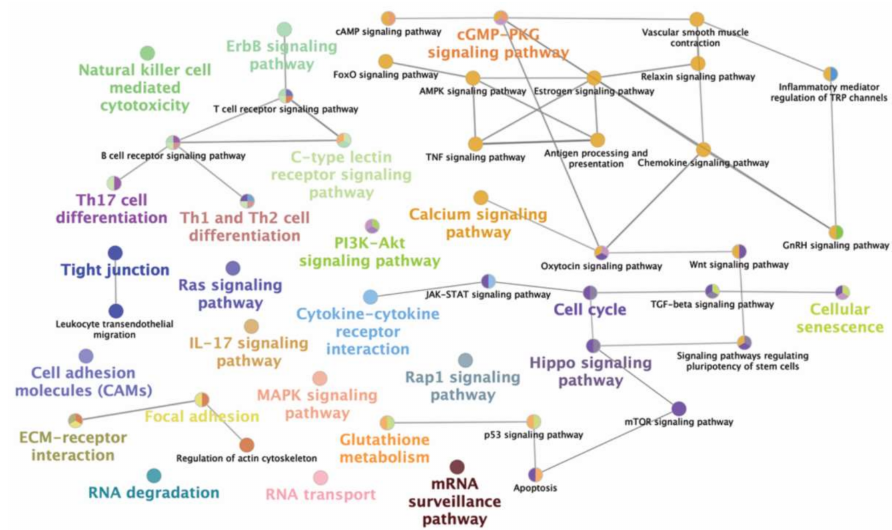
Figure 7. ClueGO network of the main pathways examined with the KEGG (Kyoto Encyclopedia of Genes and Genomes) database of predicted target-genes of di ff erentially expressed microRNAs (miRNAs) (False Discovery Rate < 0.05 and ≥ 2.0-Fold Change or ≤− 2.0) in culture media of explants (uterus and / or utero-tubal junction) exposed to Medium 199 (M199) supplemented with seminal plasma from di ff erent ejaculate fractions (sperm-rich fraction (SRF) and post-SRF) and the entire recomposed ejaculate (EE), compared with its control (M199 alone). Table 2. The main immune- and reproduction-related pathways examined with the KEGG (Kyoto Encyclopedia of Genes and Genomes) database for predicted target-genes of dysregulated miRNAs (False Discovery Rate < 0.05 and ≥ 2.0-Fold Change or ≤− 2.0) in the supernatants of genital sow explants (uterus and / or utero-tubal junction) exposed to Medium 199 (M199) supplemented with